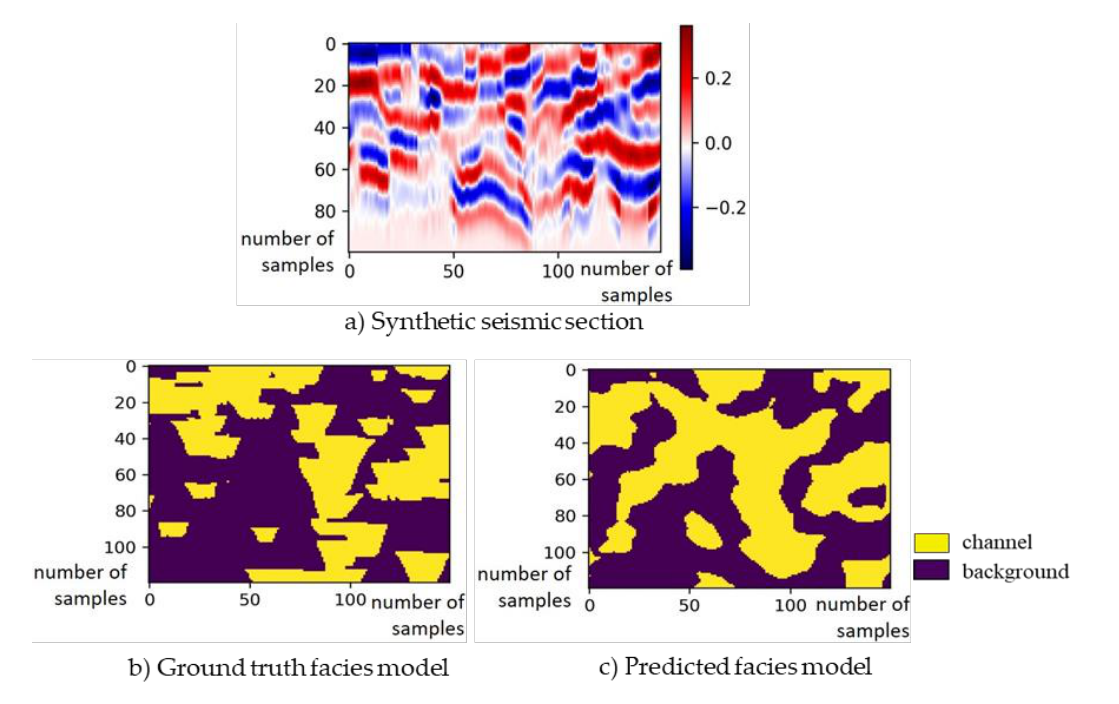
Figure 22. Synthetic seismic section ( a ), ground truth facies model ( b ) and predicted result ( c ). U-Net was trained on 13 training examples. In the prediction the true facies distribution is captured.